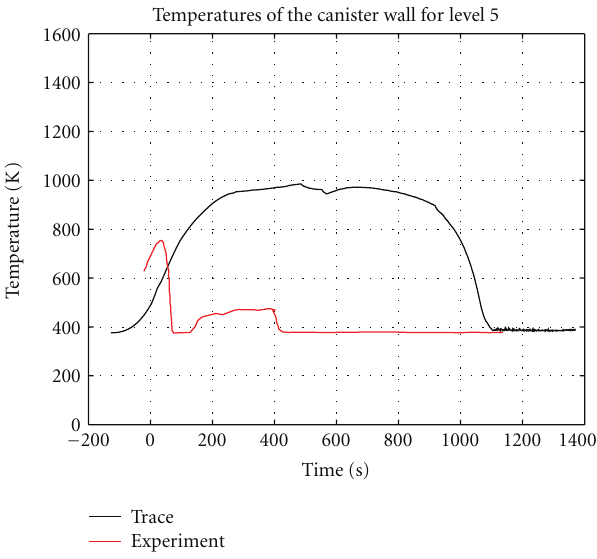
Figure 8: Temperature on the canister wall